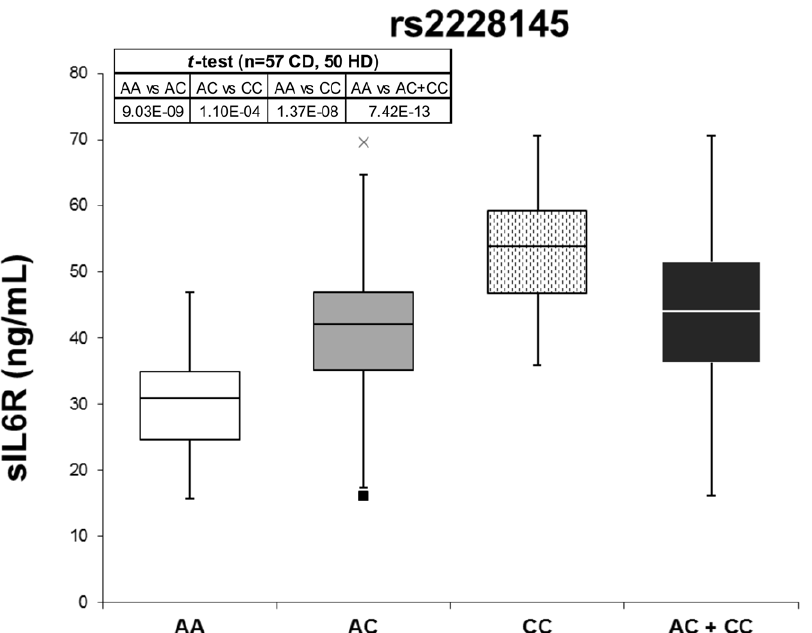
Figure 1. sIL6R levels. Levels of sIL6R in the serum of CD patients and HD were determined by ELISA. Subjects homozygous for the major allele demonstrate the lowest levels of sIL6R (white). Those who are heterozygous for the rs2228145 SNP exhibit increased levels of sIL6R in the serum (grey), while those who are homozygous for the minor allele (dots) produce the highest levels. Mean of the heterozygous and homozygous minor allele groups are also depicted (black). Min and max outliers for the heterozygous population are noted (black square and x, respectively). Differences in sIL6R levels among genotypes are highly significant.